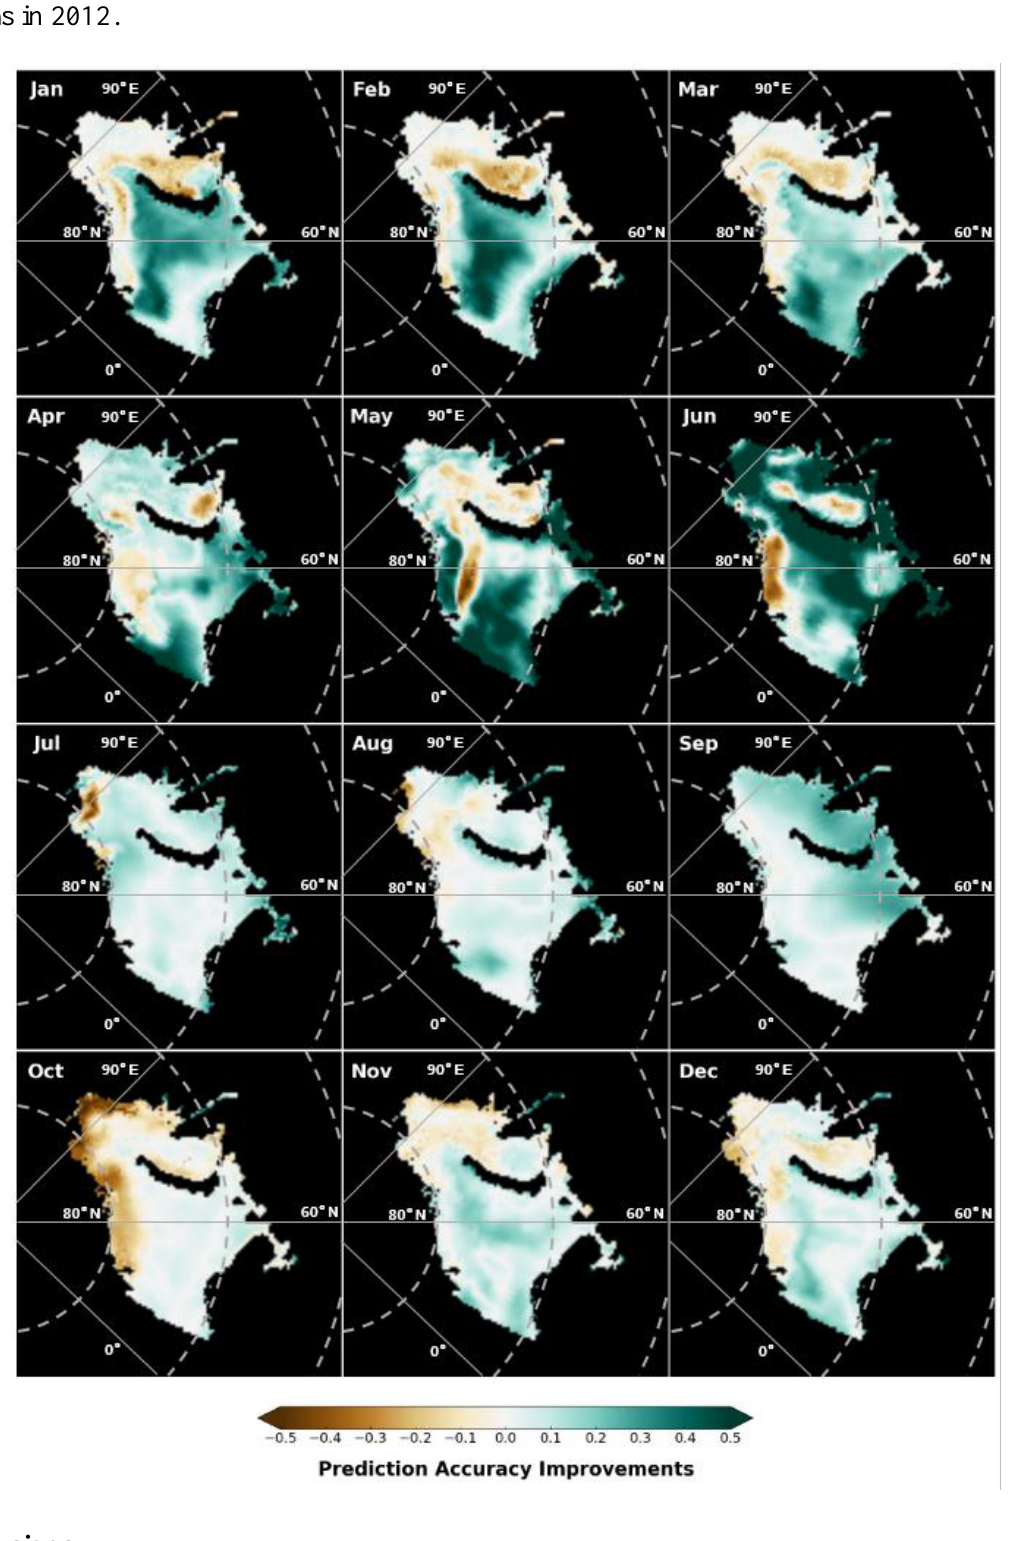
Figure 12. Prediction accuracy improvements by the ARIMA models for Barents and Kara Seas in